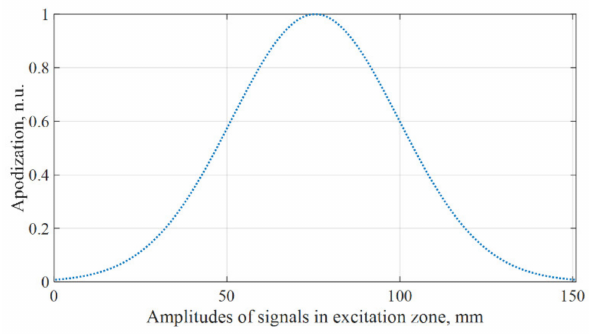
Figure 10. Apodization law versus excitation